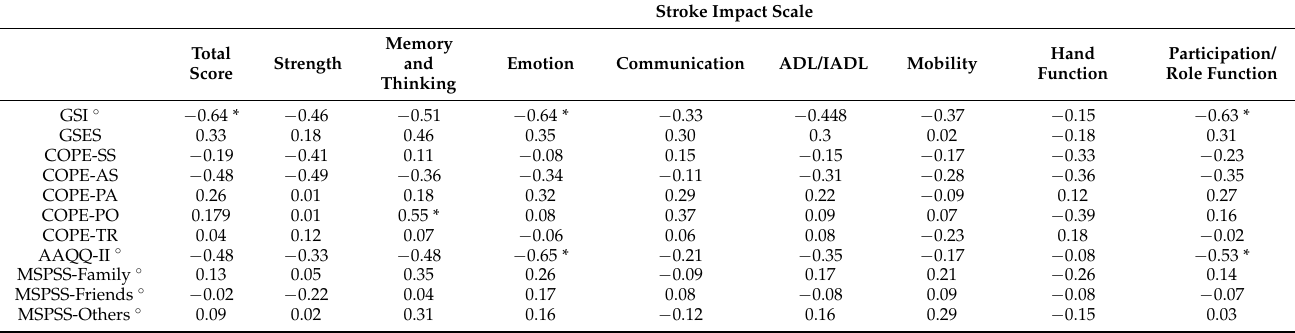
Table 5. Association between the Stroke Impact Scale scores and psychological outcomes ( n =